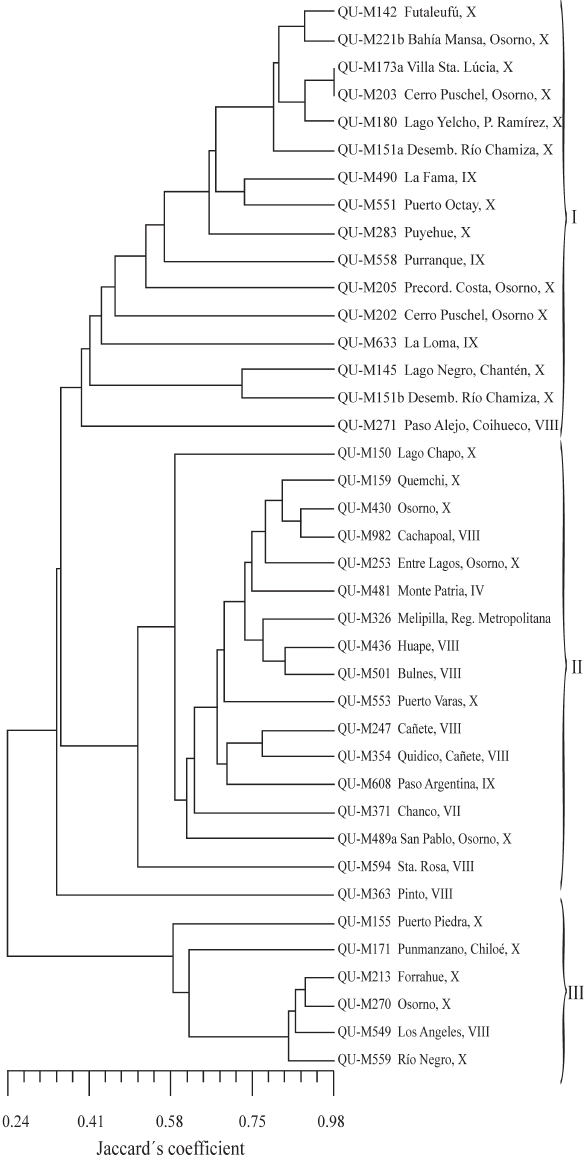
Figure 1 - Dendrogram based on random amplified polymorphic DNA (RAPD) analysis of 39 Chilean isolates of Metarhizium anisopliae var.